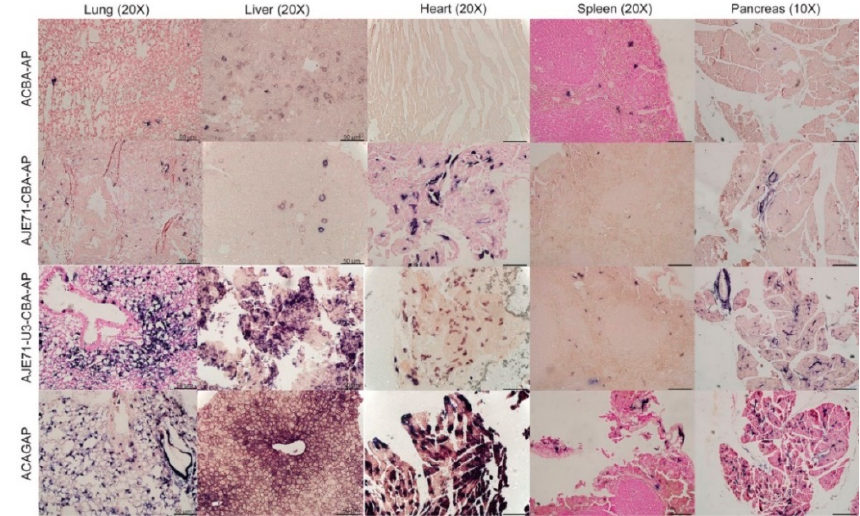
Figure 5. Representative histological alkaline phosphatase staining of tissue sections from mice transduced simultaneously via the intravenous (2 × 10 10 vg), intraperitoneal (8 × 10 10 vg), and intranasal (1 × 10 10 vg) routes with various AAV vectors bearing JE/CBA promoter/enhancer sequences and imaged 4 weeks post-transduction. Scale bar represents 50 μ M.